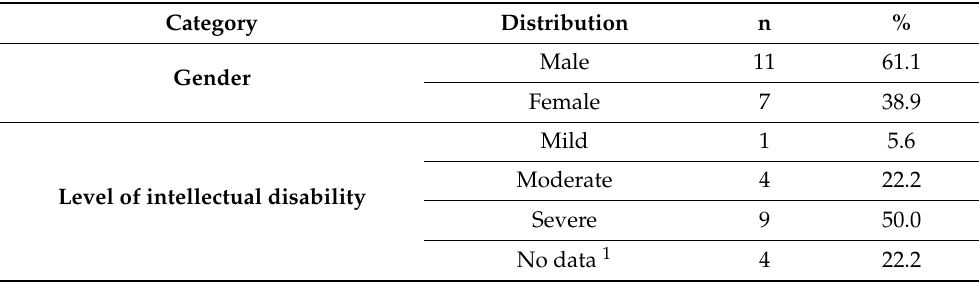
Table 1. Characteristics of the studied